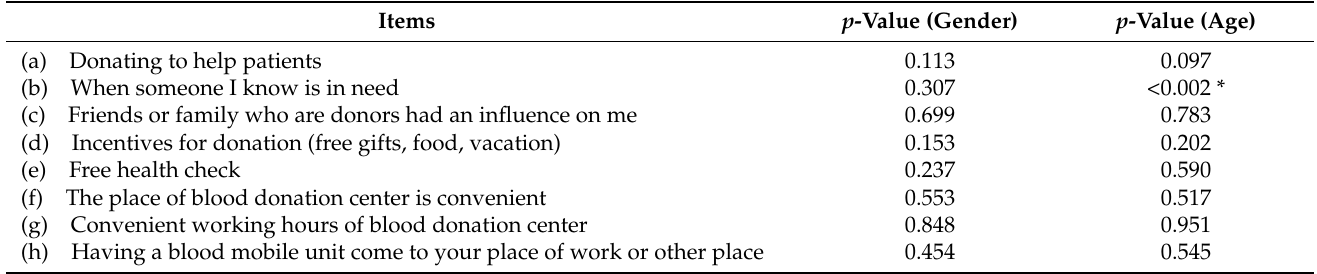
Table 4. Association between Gender/Age and Blood Donation